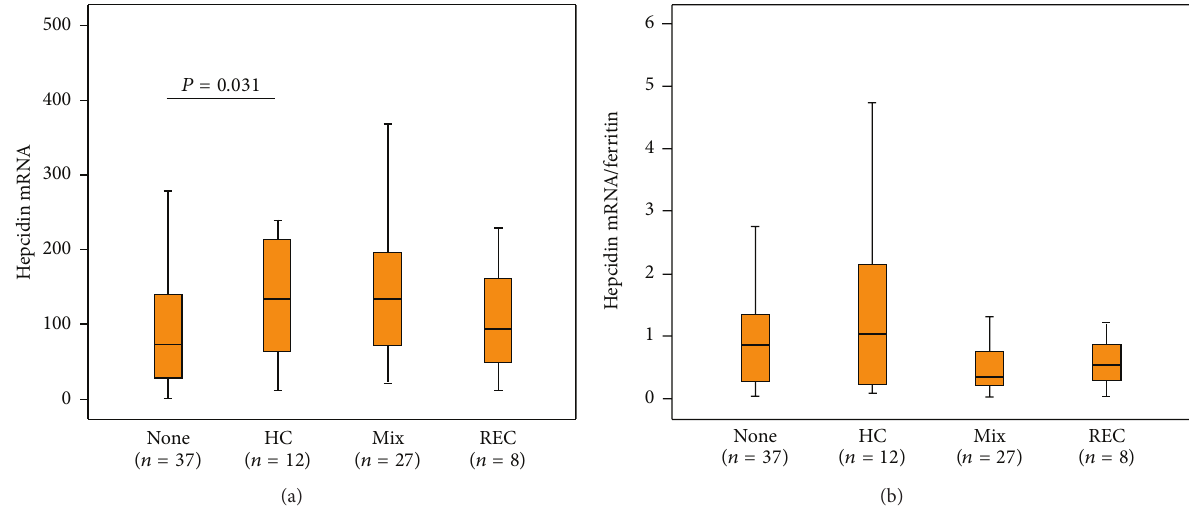
Figure 2: Distributions of absolute hepatic hepcidin mRNA levels (a) and hepcidin mRNA levels normalized to serum ferritin concentrations (b) among patients with different iron deposition patterns. mRNA levels of hepcidin were normalized to those of 𝛽 -actin. None: no stainable iron, HC: iron deposition in hepatocytes alone, Mix: iron deposition in mixed hepatocytes/reticuloendothelial cells, and REC: iron deposition in reticuloendothelial cells alone. Differences between the None and HC groups were analyzed by post hoc comparisons (Bonferroni